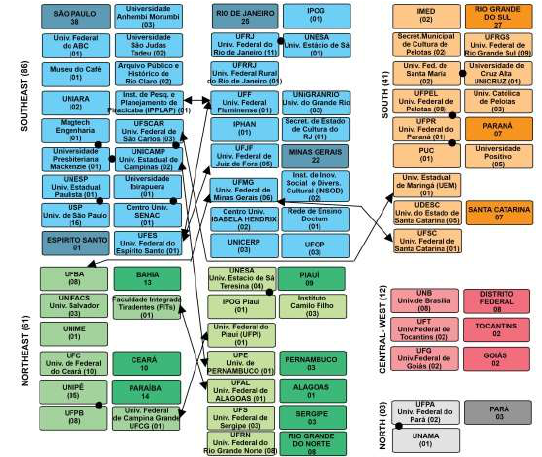
Figure 2: Interaction of Brazilian researchers by